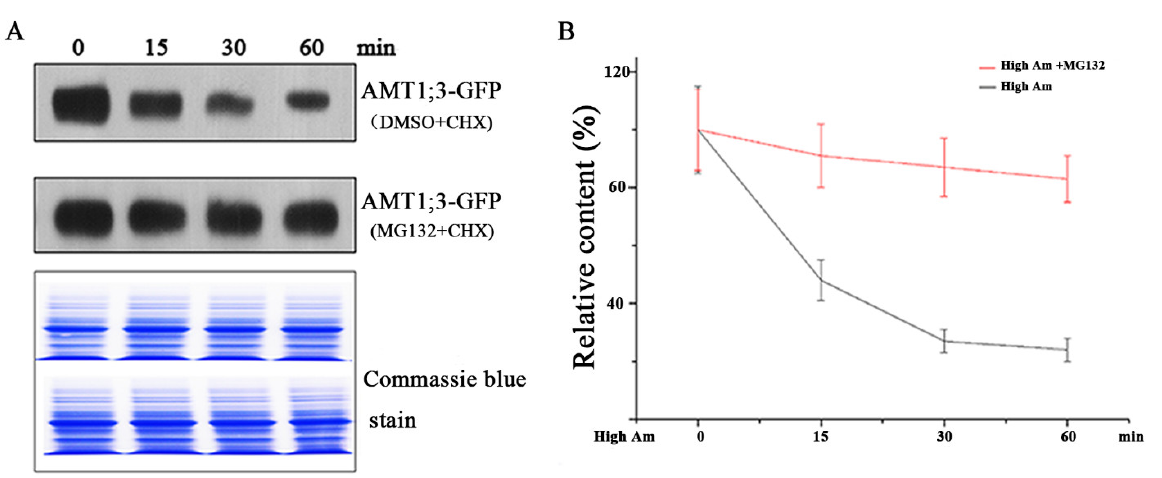
Figure 1. Ubiquitylation participates in the degradation of AMT1; 3 proteins under high ammonium stress. ( A ) Total proteins were isolated from AMT1;3-EGFP seedlings that had been treated with DMSO and MG132, in the presence of CHX, with high ammonium treatment for 0, 15, 30, 60 min. The total proteins were separated by SDS-PAGE and immune detected with GFP antibody. ( B ) Relative contents of AMT1;3-EGFP (per unit of total protein). Error bars represent standard errors.